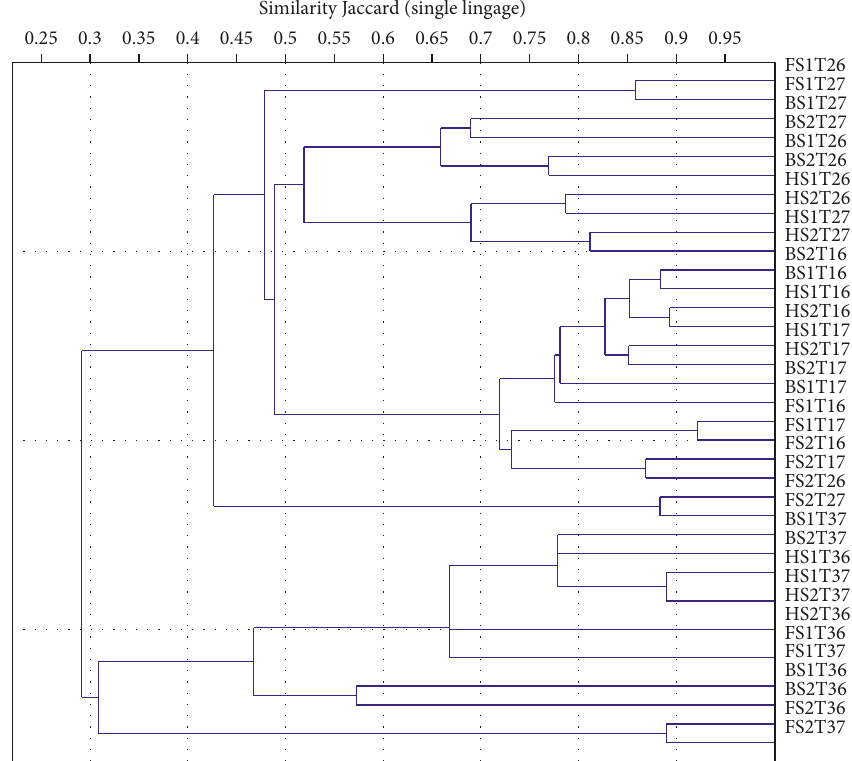
Figure 8: Dendrogram derived from the cluster analysis (Jaccard similarity index) during the study periods (2016-2017). Numbers T1, T2, and T3 attached to the transects represent the sampling